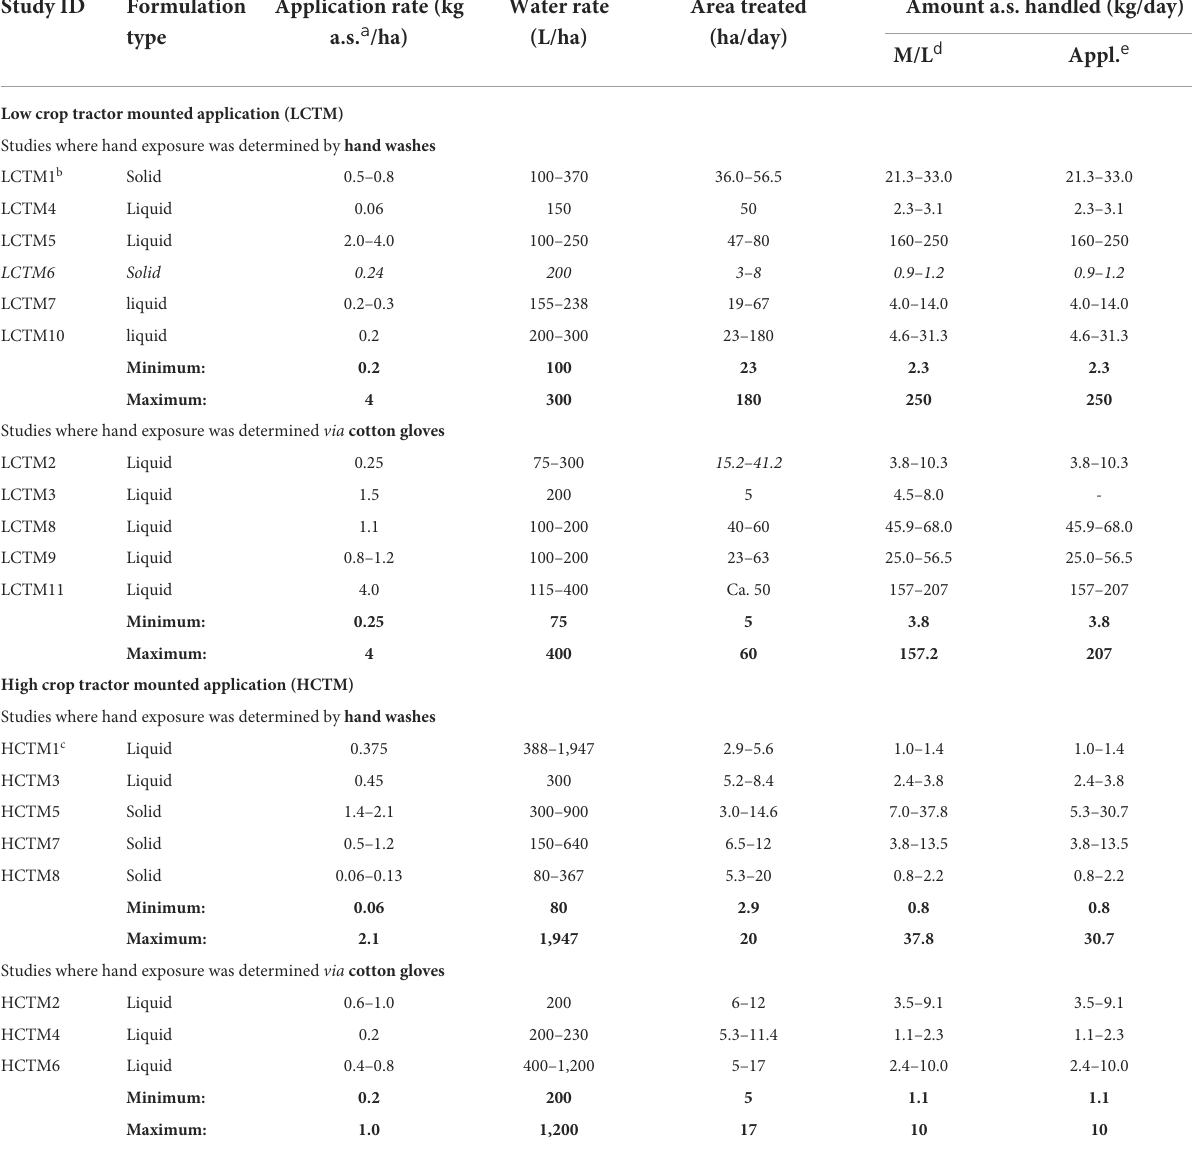
TABLE 1 Summary of data from the spray applications performed in low (LCTM) and high (HCTM)